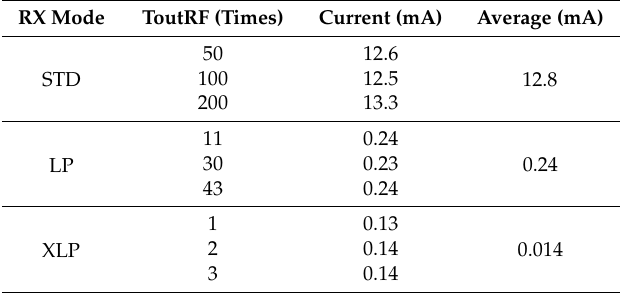
Table 7. Average current drained in reception mode.